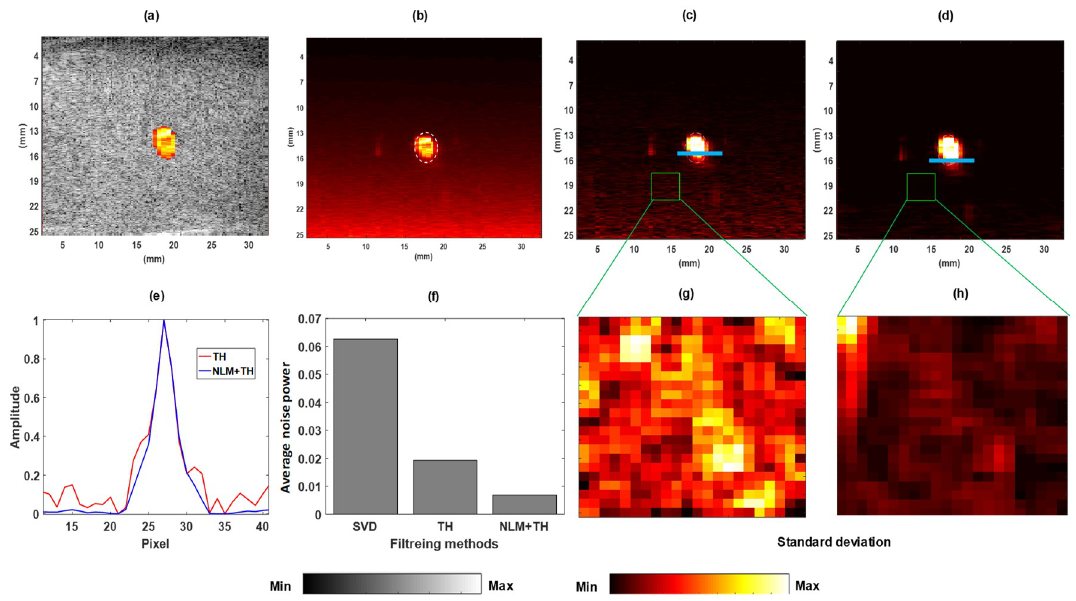
Figure 2. Flow phantom experiment results: ( a ) overlaid power Doppler image and B-mode; ( b ) unbiased singular value decomposition (SVD)-filtered image; ( c ) filtered image using SVD + top-hat (SVD+TH); ( d ) filtered image using proposed method non-local mean + TH (NLM+TH); ( e ) corresponding signal amplitude along blue lines in ( c , d ); ( f ) average noise power values for ( b – d ); and ( g , h ) are standard deviation maps for identified green color outlined background area in ( c , d ), respectively.